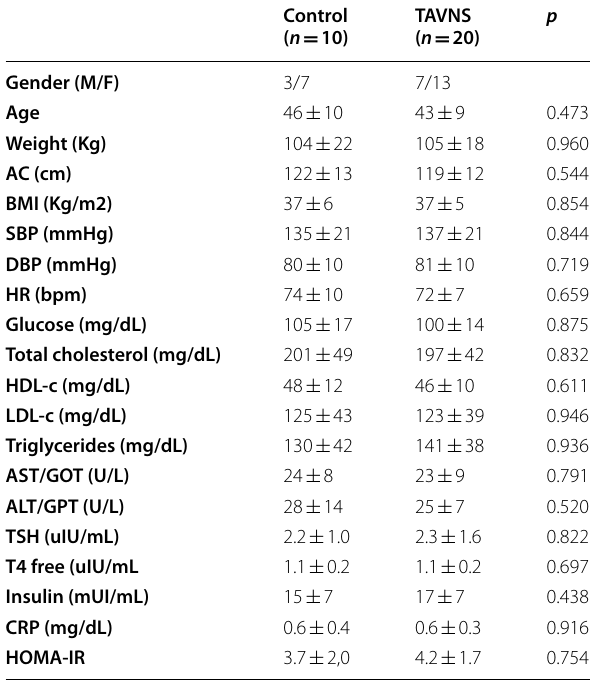
Table 2 Effect of a single TAVNS on hemodynamic parameters and heart rate variability components in MetS